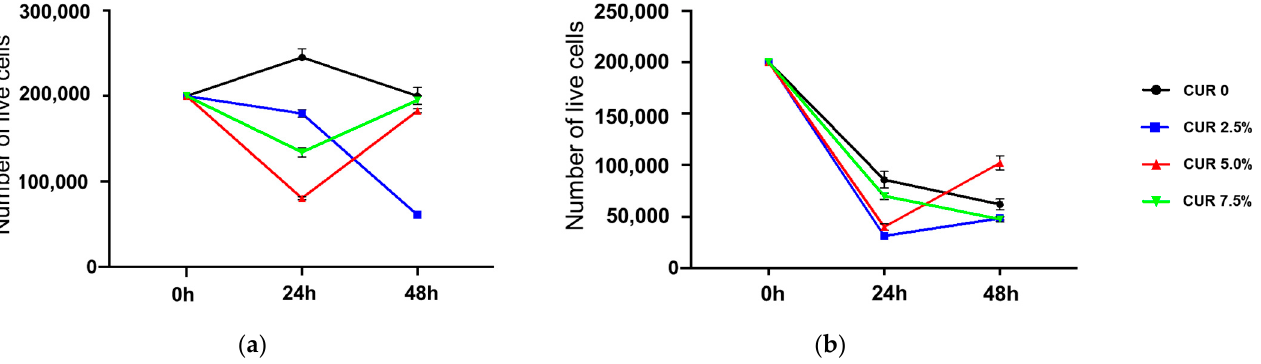
Figure 8. Cell viability profile of SCC-25 cells after 24 and 48 h of incubation with CUR-loaded ( a ) CUR@H ALG and ( b ) CUR@H ALG-GO . Data are expressed as means ± SD of three counts. The effects of unloaded the H ALG and H ALG-GO samples (Figure 8, black lines) were similar to those recorded for the HBEpC, with a higher toxicity recorded for H ALG-GO . More interesting results were obtained when the CUR-loaded samples (2.5%) were used. Here, the polyphenol was found to counteract cell death upon loading on H ALG , while the cytotoxicity was retained and even enhanced when H ALG-GO was used as a delivery device (Figure 9). It is evident, indeed, that either the cell number or morphology was altered with increased CUR concentrations, suggesting the induction of cell death.